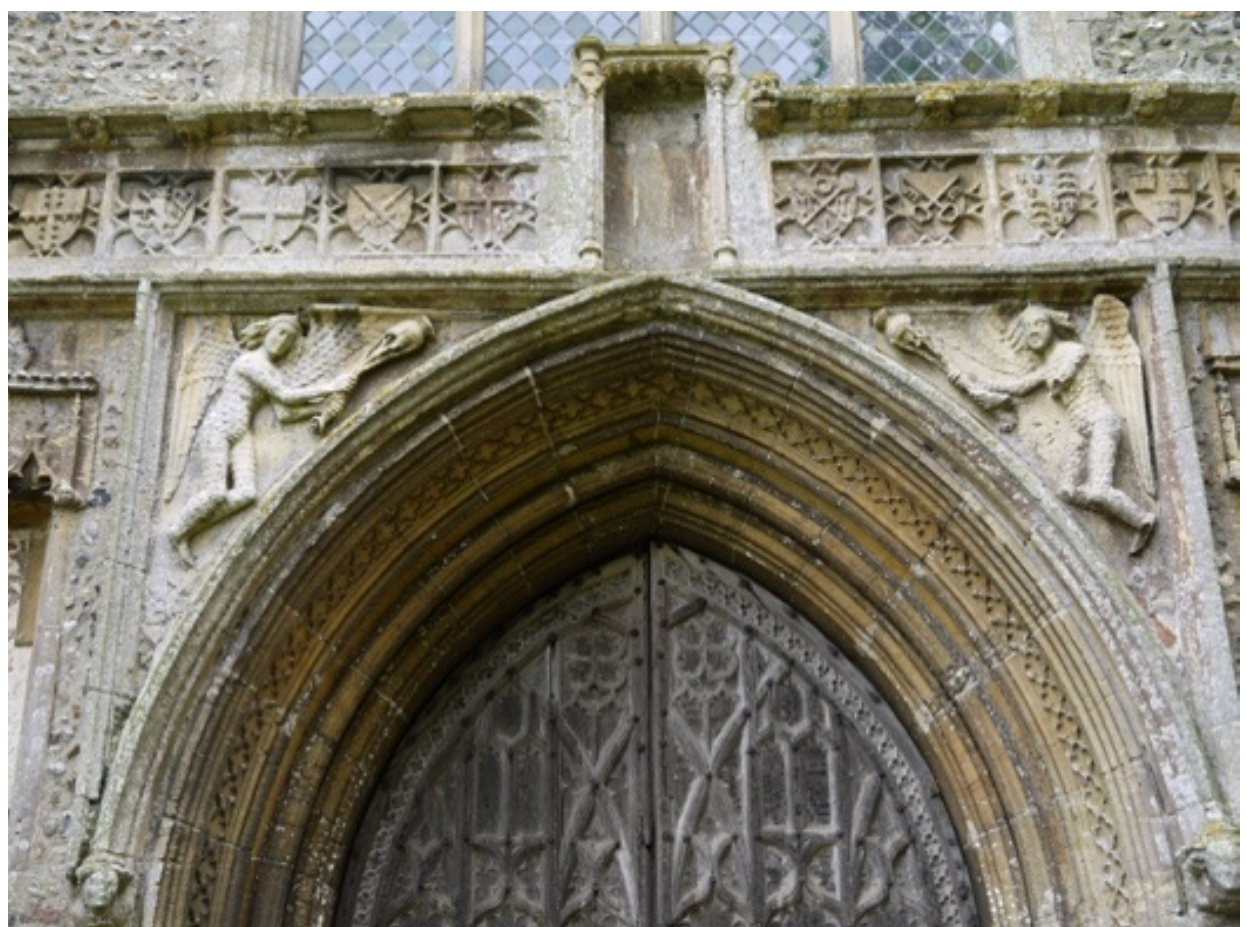
Figure 4. Stone angels in the spandrels of the west door at Salle.